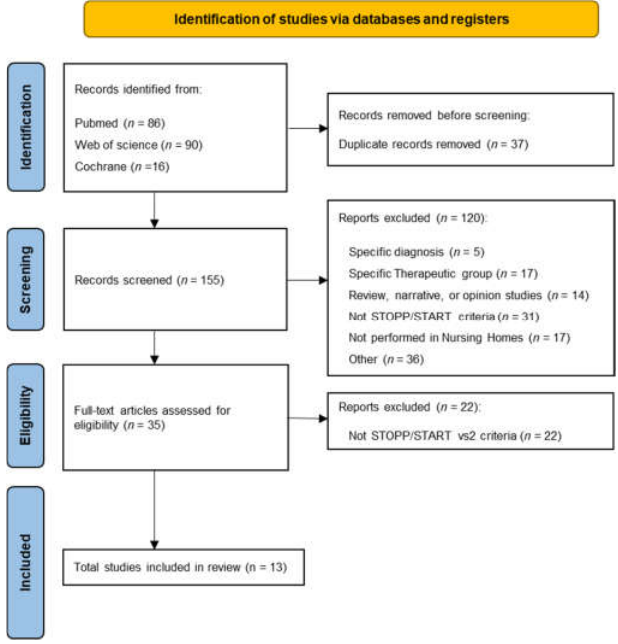
Figure 1. PRISMA flow diagram for the selected studies.